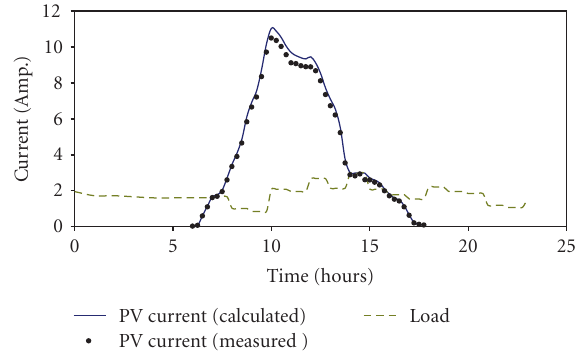
Figure 4: PV current output and load current for the selected day (November 19,